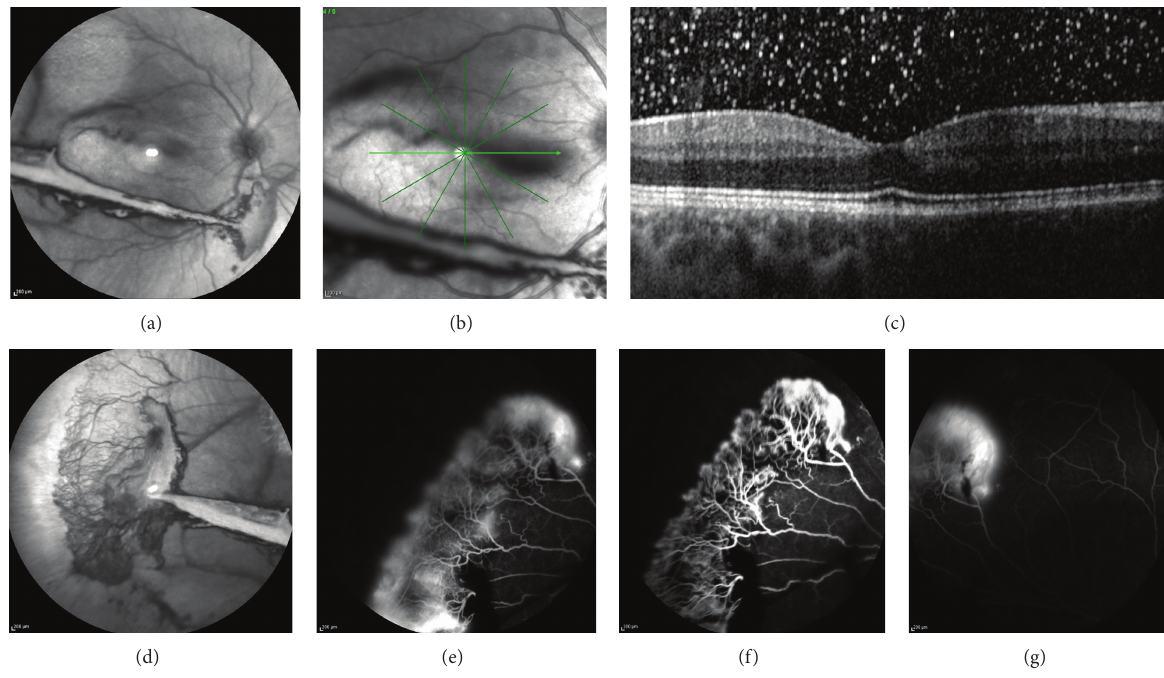
Figure 1: (a) Infrared fundus photo, showing vitreous hemorrhage in the right eye; (b, c) optical coherence tomography, showing no macular abnormalities; (d) infrared fundus photo, showing sea fan neovascularization at the temporal periphery; (e–g) fluorescein angiography, showing leakage from the neovascularization and ischemia in the